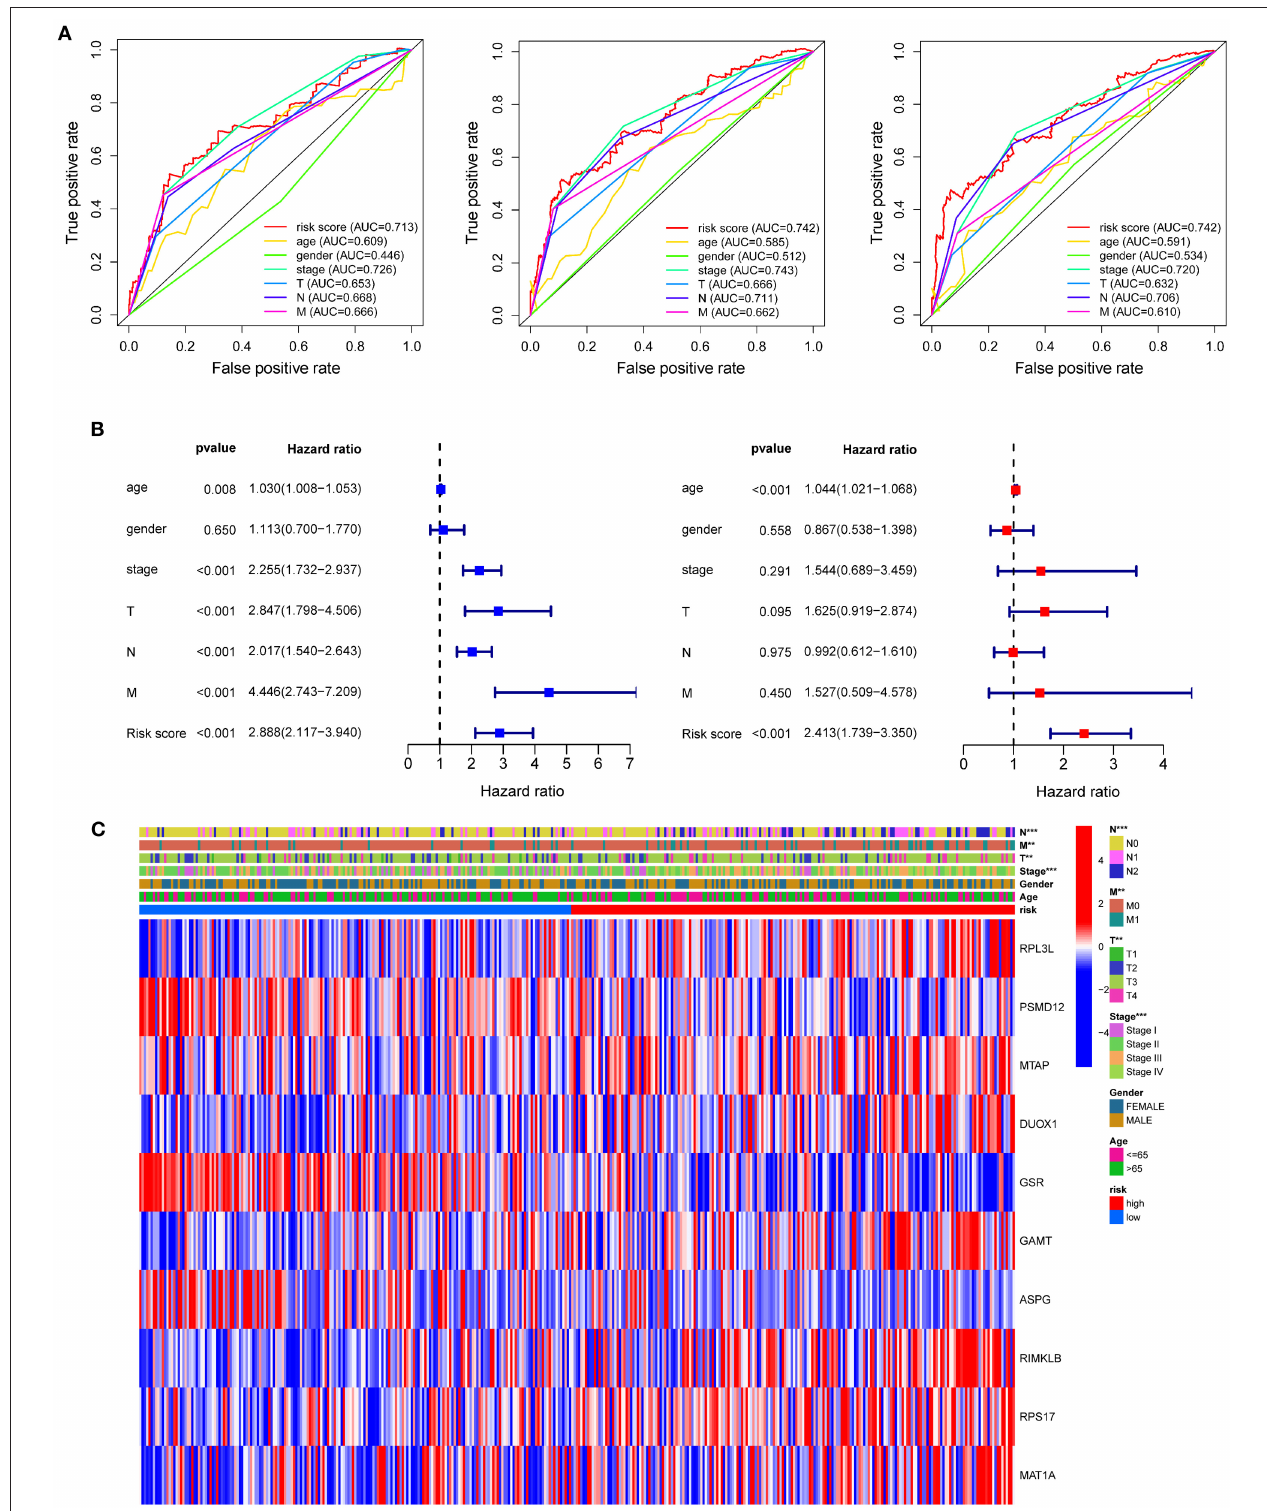
FIGURE 4 | The predictive efficacy of the risk model and the relationship between risk score and clinical outcome, pathological characteristics, and prognostic value of COAD. (A) ROC curve to evaluate the predictive efficacy of the risk model. (B) Univariate Cox regression analysis and multivariate Cox regression analysis of clinicopathological characteristics and risk score. (C) The relationship of clinicopathological characteristics and risk scores between high- and low-risk groups from TCGA dataset. ** P < 0.01 and *** P < 0.001.